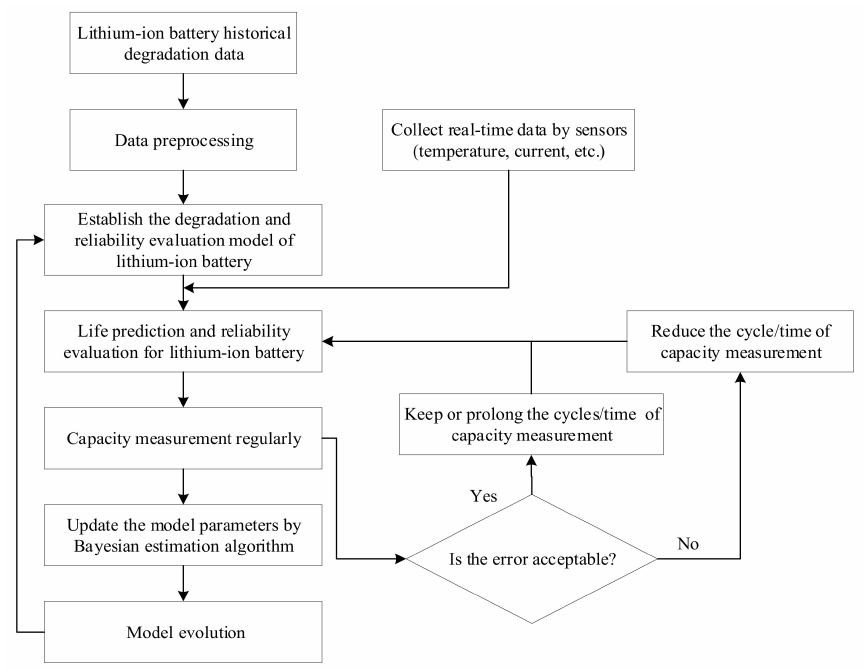
Figure 2. Flow chart of the Bayesian-based evolution method for the digital twin